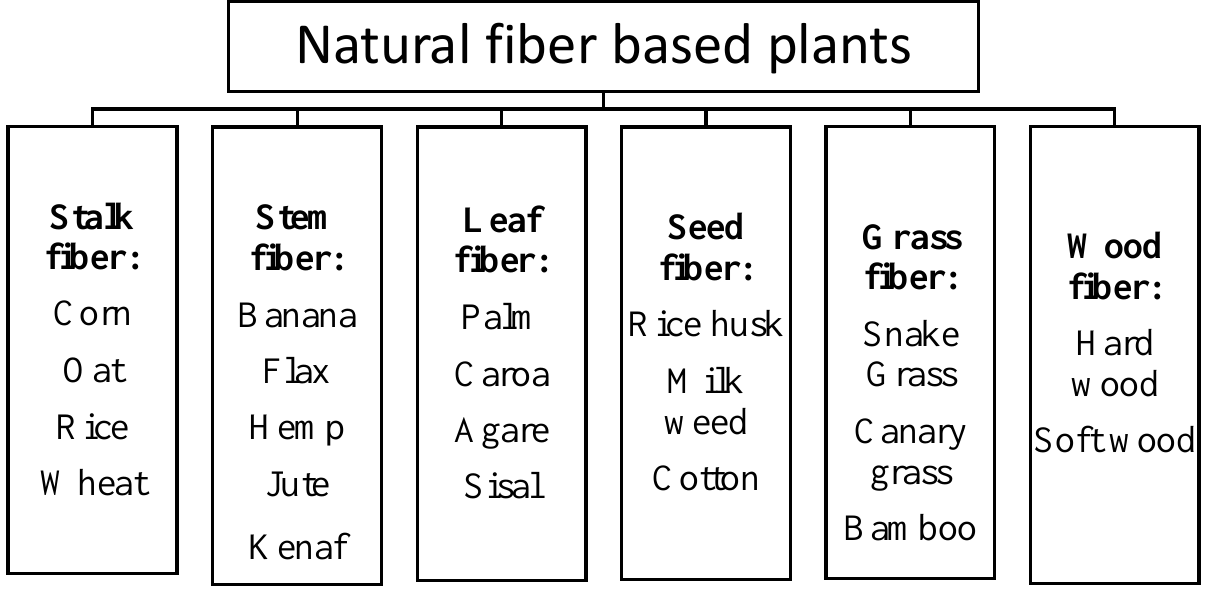
Figure 1. Classification of natural fiber [13,24,28].